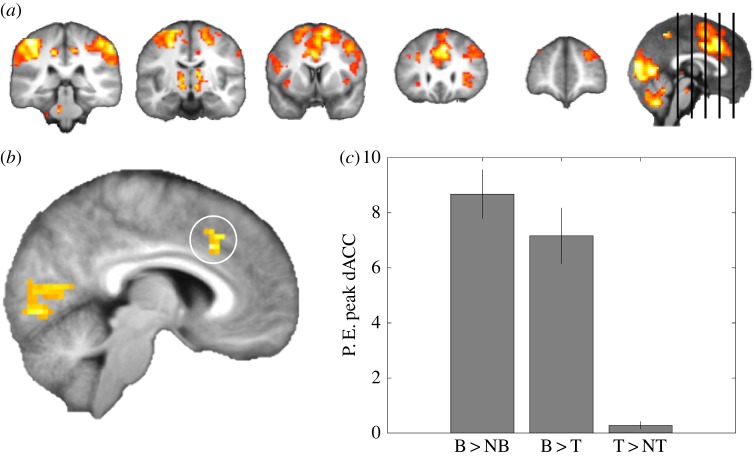
Backtracking activates a range of frontal areas, as well as the dorsal anterior cingulate cortex (dACC). (a) The superior frontal gyrus and right lateral PFC are activated during backtracking compared to non-backtracking events. Figures are thresholded at p = 0.005 uncorrected. (b) Whole-brain results (FWE p < 0.05) revealed a significant activation in the dorsal anterior cingulate cortex. (c) Extracting parameter estimates (P.E.) from the peak voxel in dACC (MNI: x: 6, y: 20, z: 35, note Kaplan et al. [20,23] = x: 6, y: 23, z: 37) show that backtracking activates this region significantly. Bar plot is for illustration purposes only to highlight the effect, error bars represent s.e.m. B, backtracking; NB, non-backtracking; T, turns. (Online version in colour.)